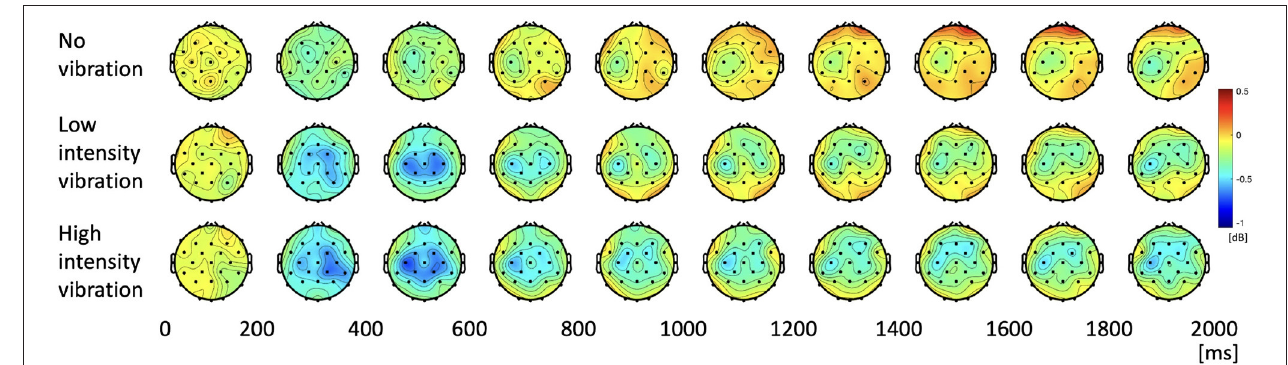
FIGURE 6 | Topographies of beta power spectral density during the task